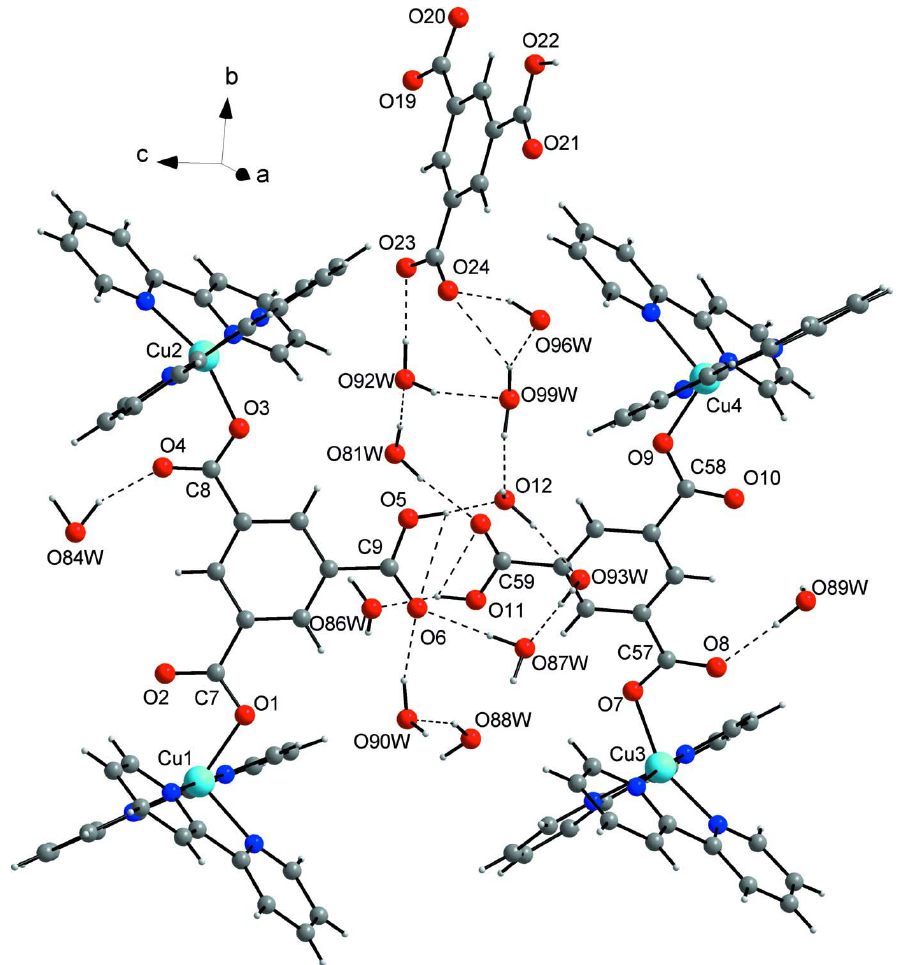
Figure 2 Part of the crystal structure showing the formation of O—H···O hydrogen bonds. Most of the water molecules of crystallization, and free Hbtc anions and bpy molecules have been omitted for